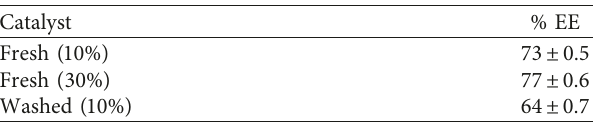
Figure 5: Infrared spectra of the CaO-ZnO catalyst. Table 1: Percentage of ethyl esters generated by biodiesel synthesis using mixed CaO-ZnO as a catalyst.